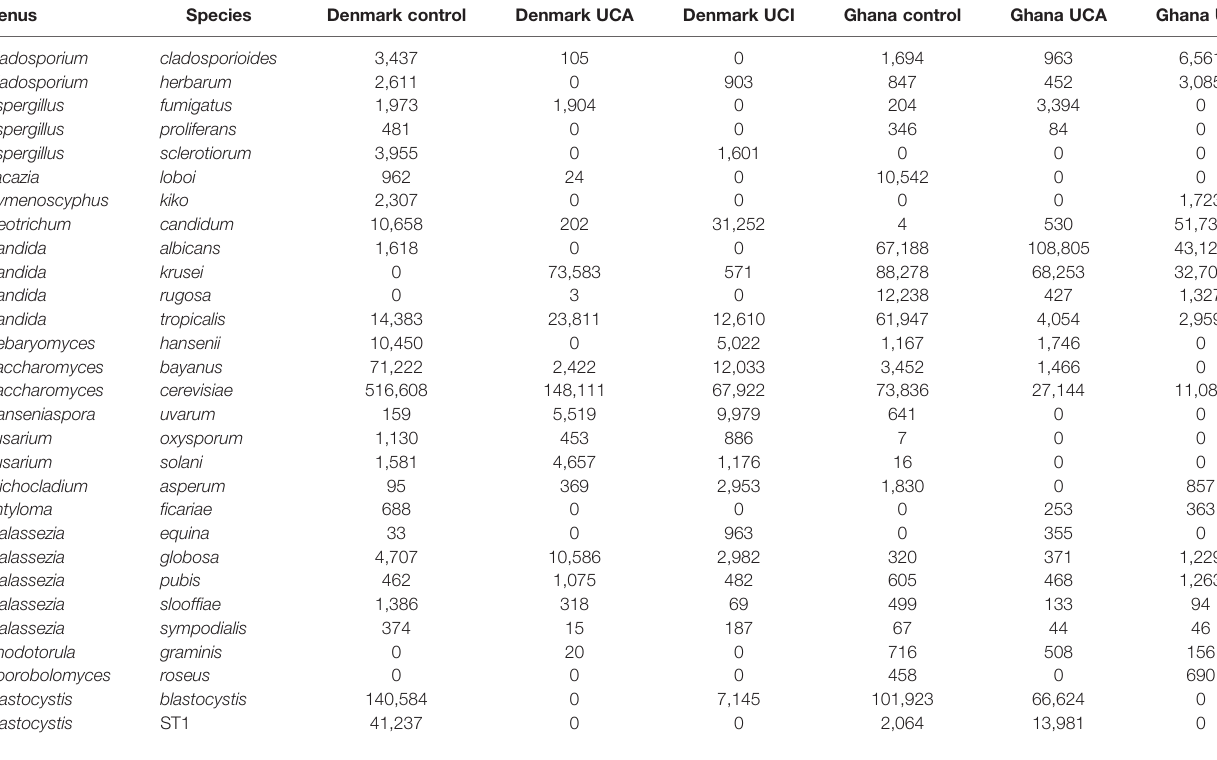
TABLE 4 | Total OTUs of selected eukaryotic species with increased abundance in the study